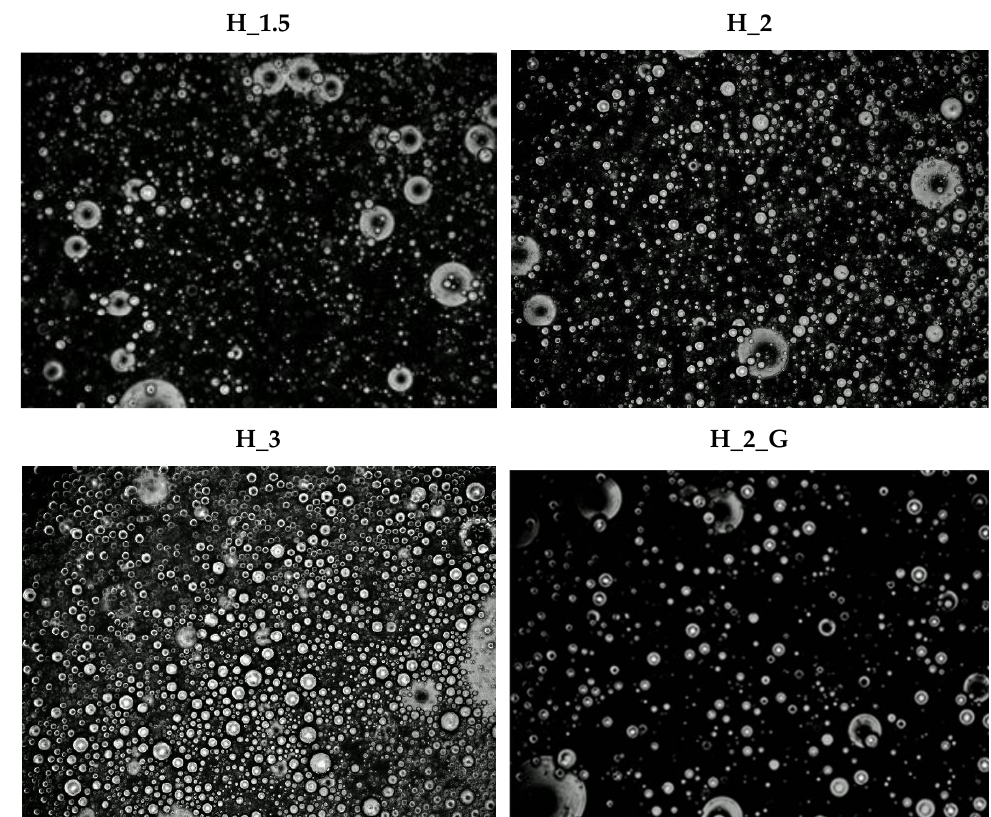
Figure 2. Microphotographs of O/W emulsions (dilution 1:10) after a storage time of 3 h (magnifica- tion 20×).